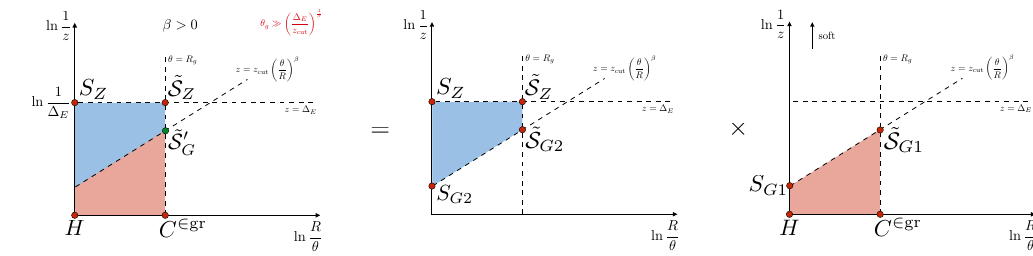
Figure 12 . Lund diagram analysis in which regime B is written as a conditional probability for ∆ E given a value of θ g , and the θ g cross